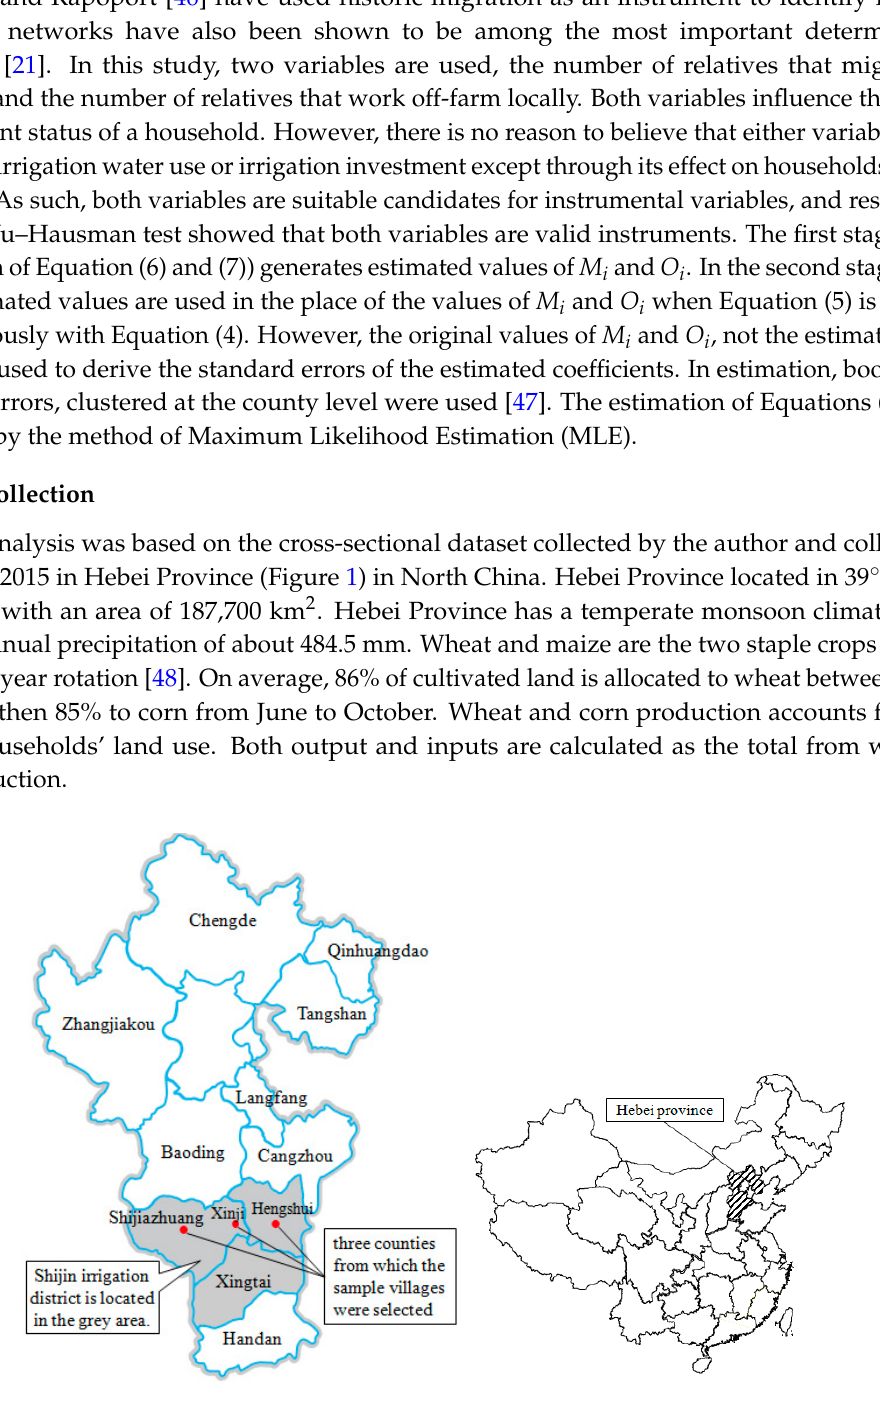
Figure 1. Location of sample area and Hebei Province in China.